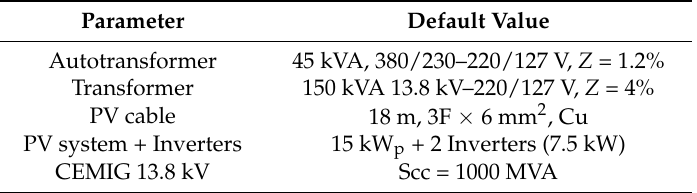
Table 1. Parameters of the CERIn (Center of Excellence in Smart Grids)